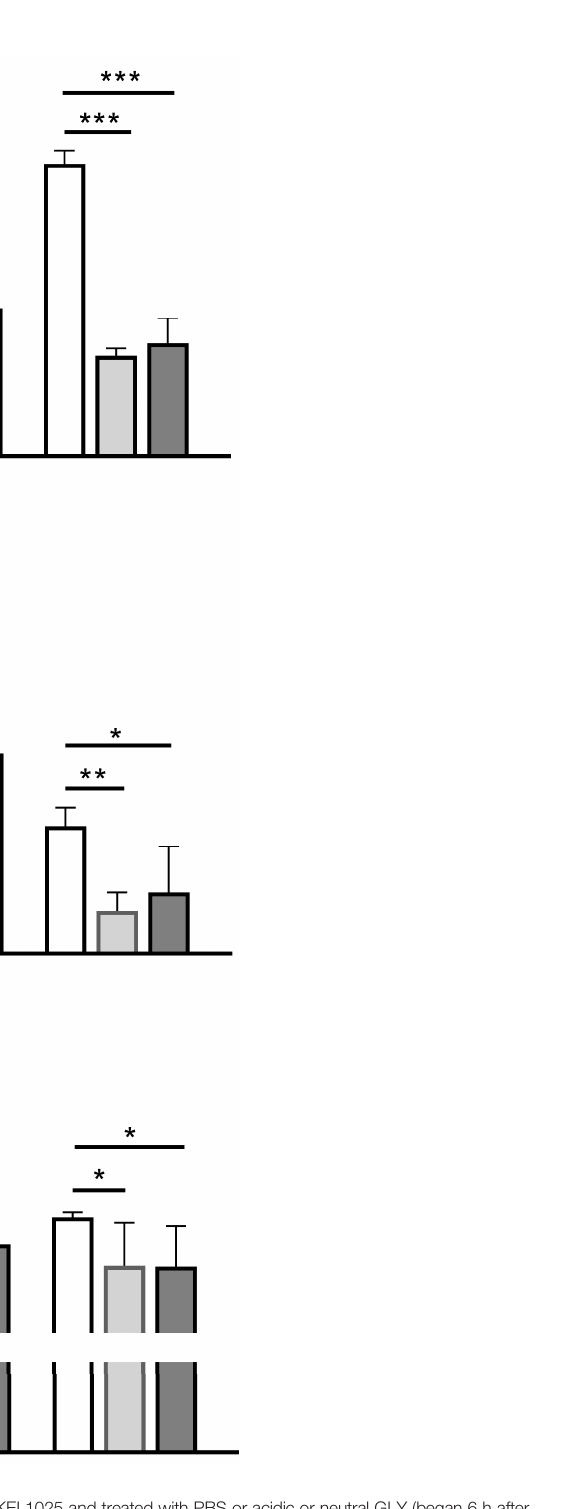
FIGURE 6 | Effects of GLY pH on protein levels of cytokines in corneas infected with KEI 1025 and treated with PBS or acidic or neutral GLY (began 6 h after infection). ELISA detected protein levels of HMGB1 (A) , TNF- a (B) , and CXCL2 (C) at 3 and 5 days p.i. Signi fi cantly reduced protein levels for all three cytokines after acidic or neutral GLY vs . PBS treatment were observed only at 5 days p.i. Data are expressed as mean ± SEM (*p < 0.05, **p < 0.01, ***p < 0.001, n =